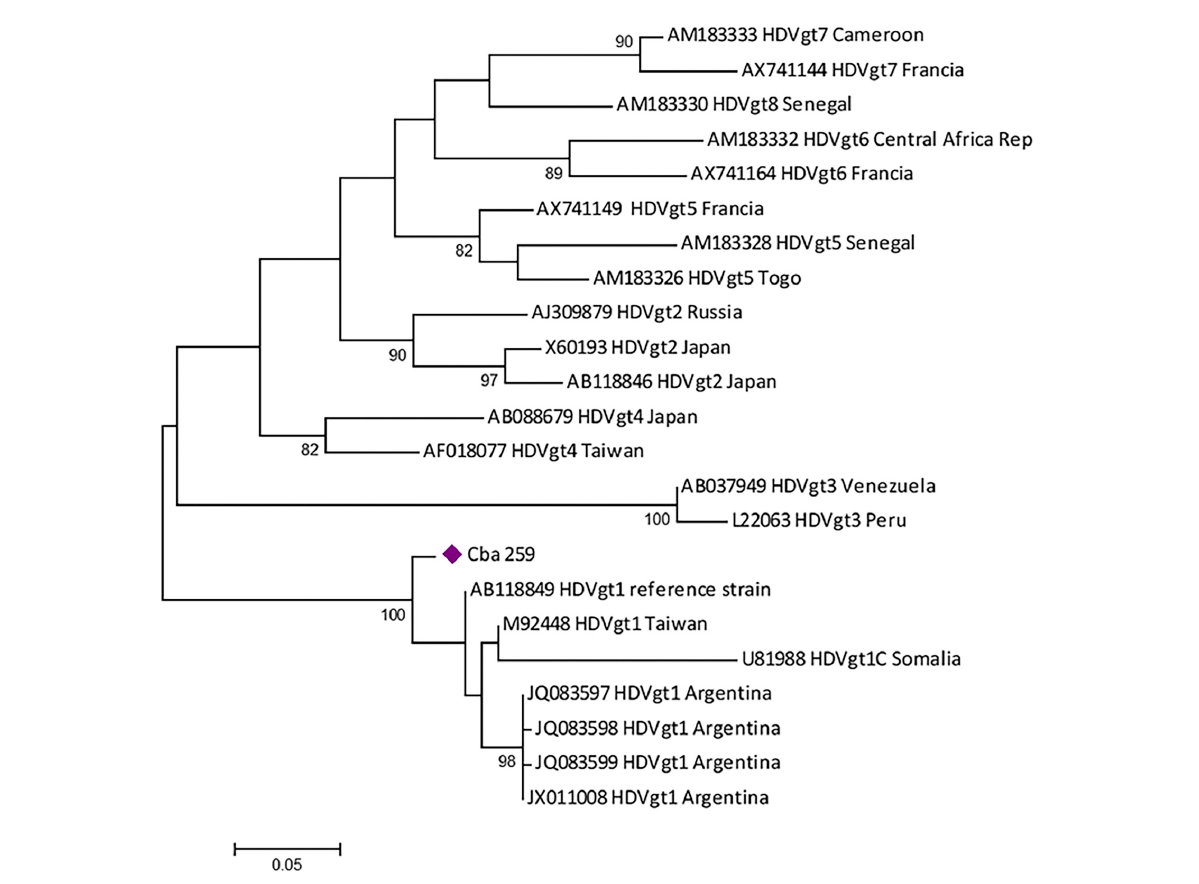
FIGURE5 Maximum likelihood phylogenetic tree obtained using sequences of 326 nucleotides, corresponding to the partial HDAg region of hepatitis D virus (HDV), constructed with MEGA v.6 (bootstrap: 1000 replicates). The tree includes the positive sample obtained (violet diamond) and the reference sequences from each genotype available at